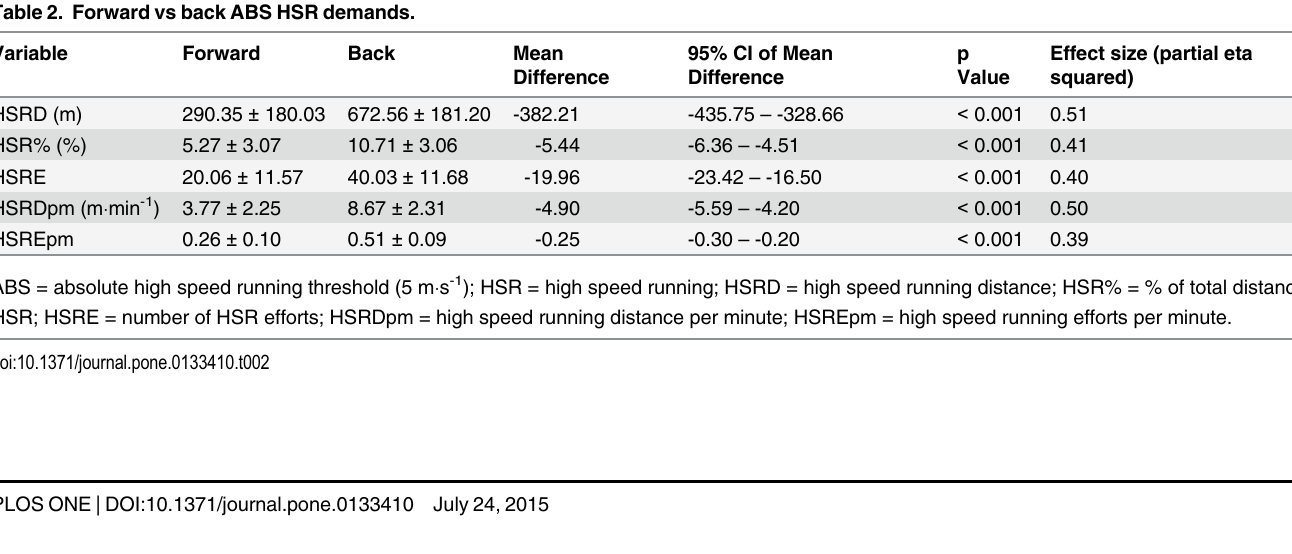
HSR metrics for backs (Table 1) with the use of an absolute threshold. In the absolute HSR